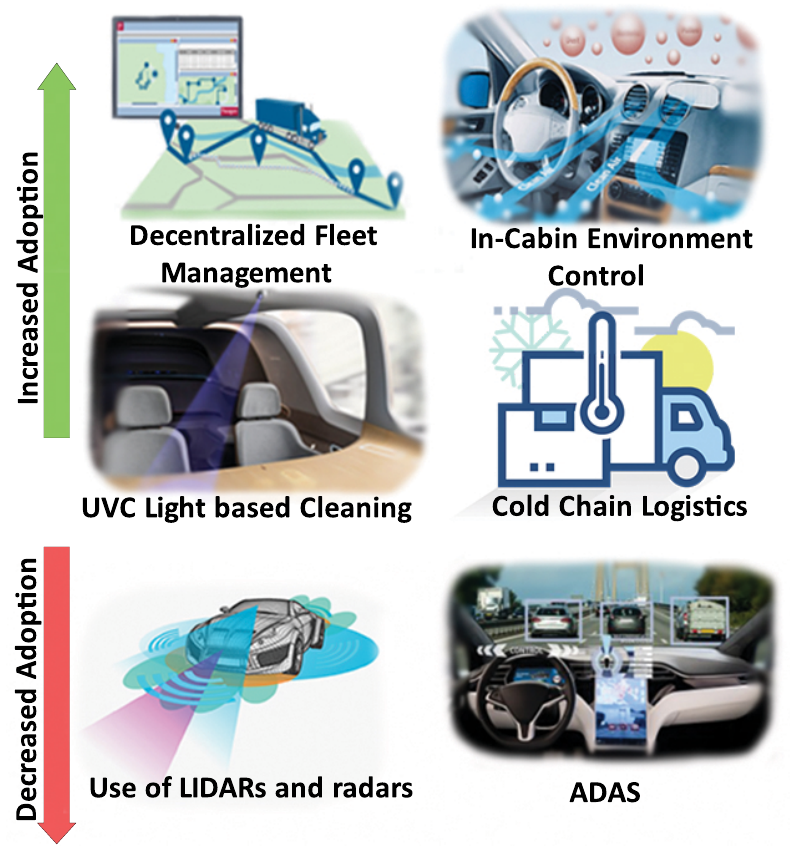
Figure 6. Summary of IoT Adoption in